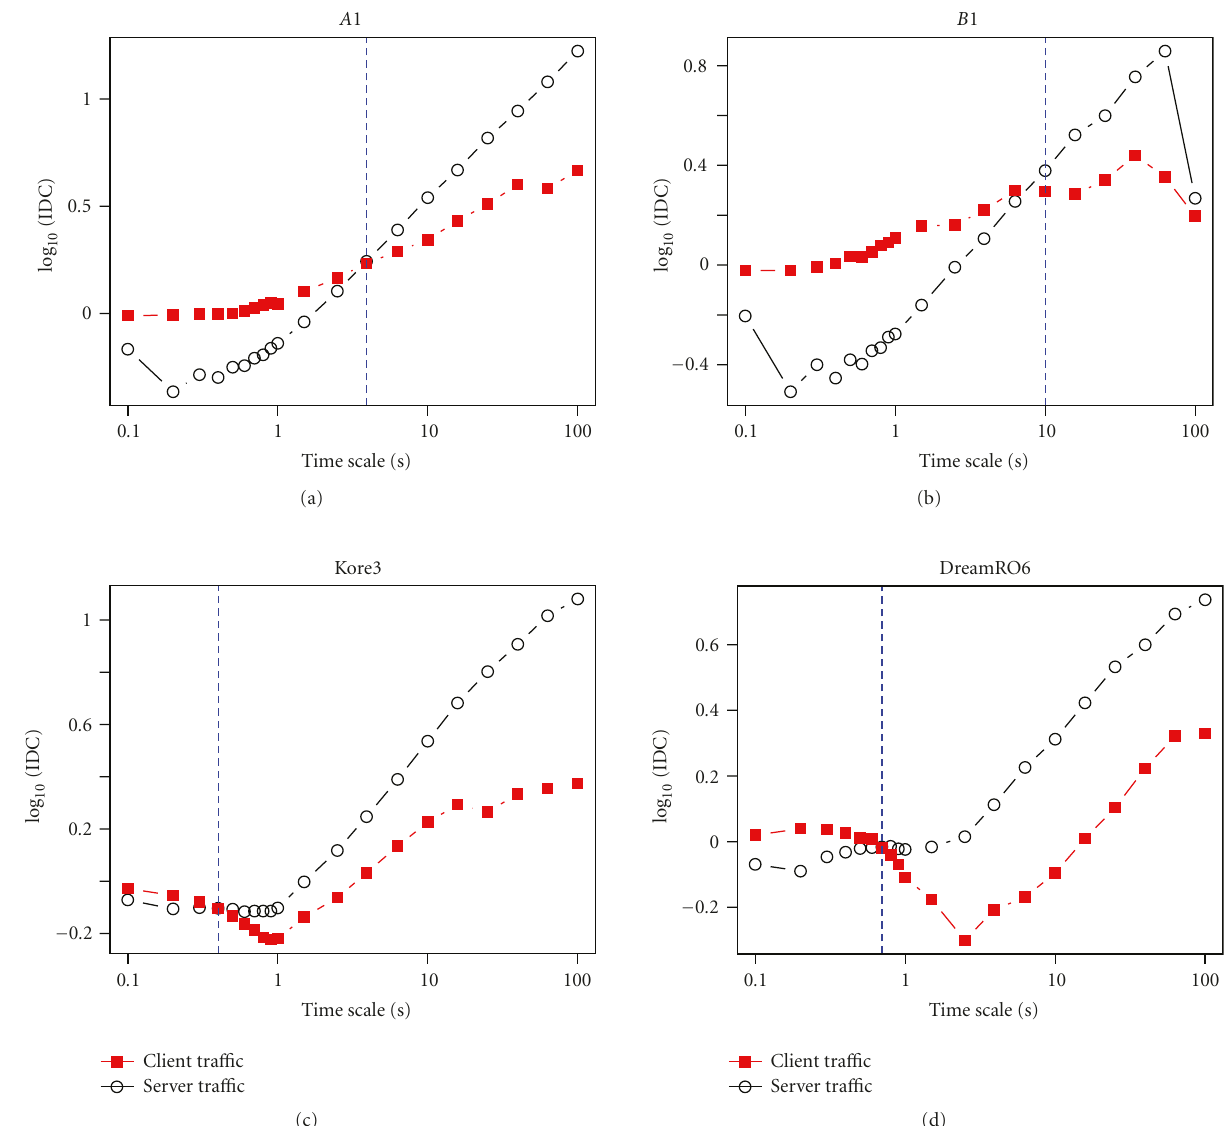
Figure 11: IDC magnitude comparison. The IDC of client packet arrivals versus the IDC of server packet arrivals.